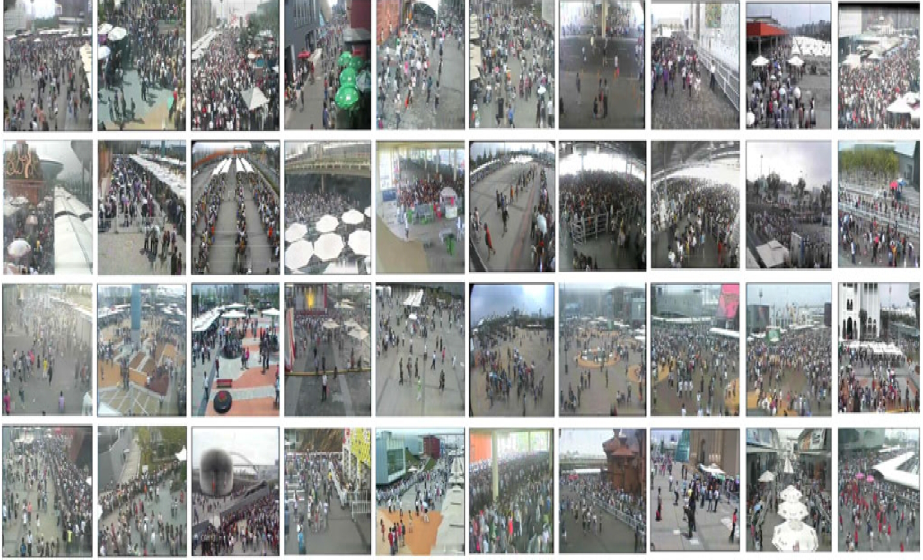
Figure 2. Some sample images from World Expo dataset.